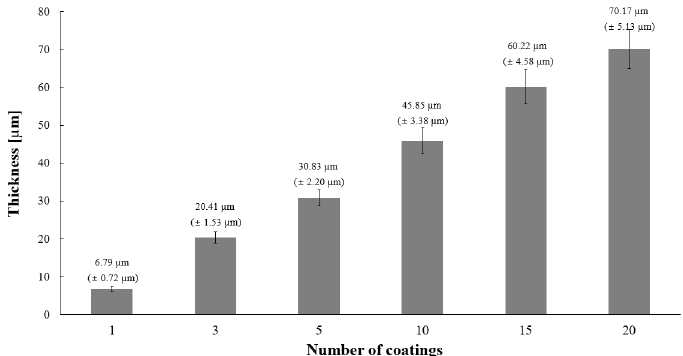
Figure 4. RGO membrane thicknesses according to the number of coatings (average values and standard deviations are listed).